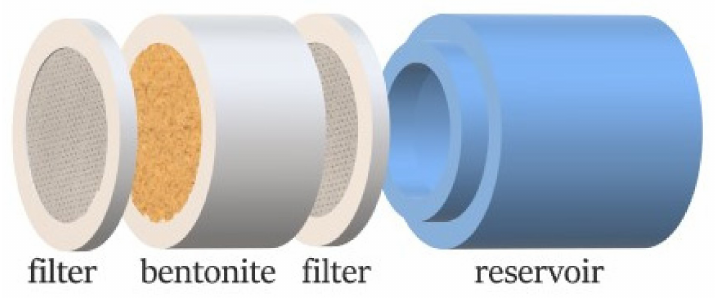
Figure 1. Scheme of a diffusion